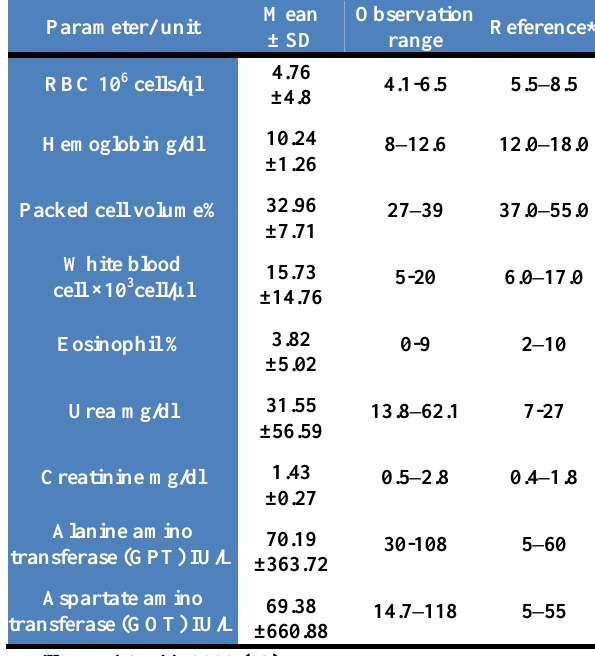
Table, 1: Hematological and biochemical parameters of dogs infected with